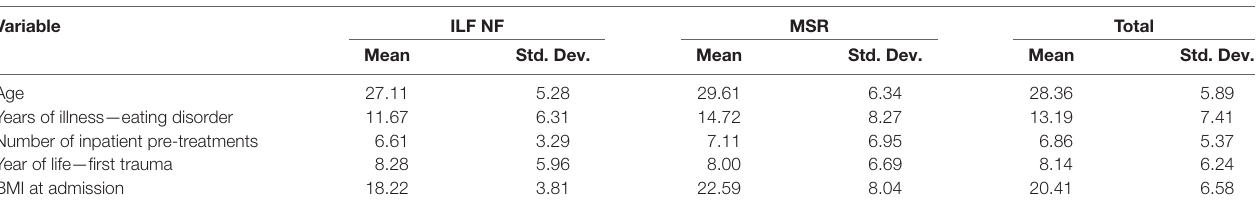
TABLE 1 | Illness-related characteristics of the sample.